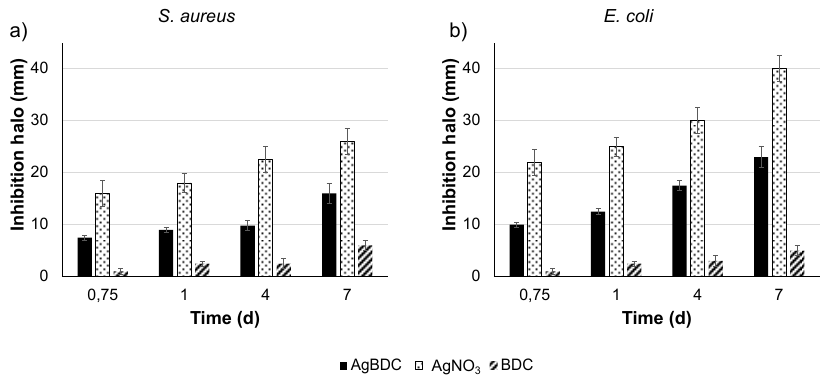
Figure 3. Inhibition halo (mm; determined by Image J) of AgBDC against: ( a ) S. aureus and ( b ) E. coli.